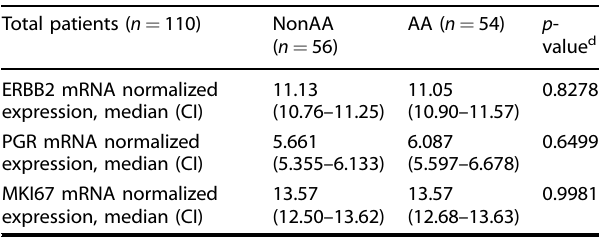
Table 1. Patient